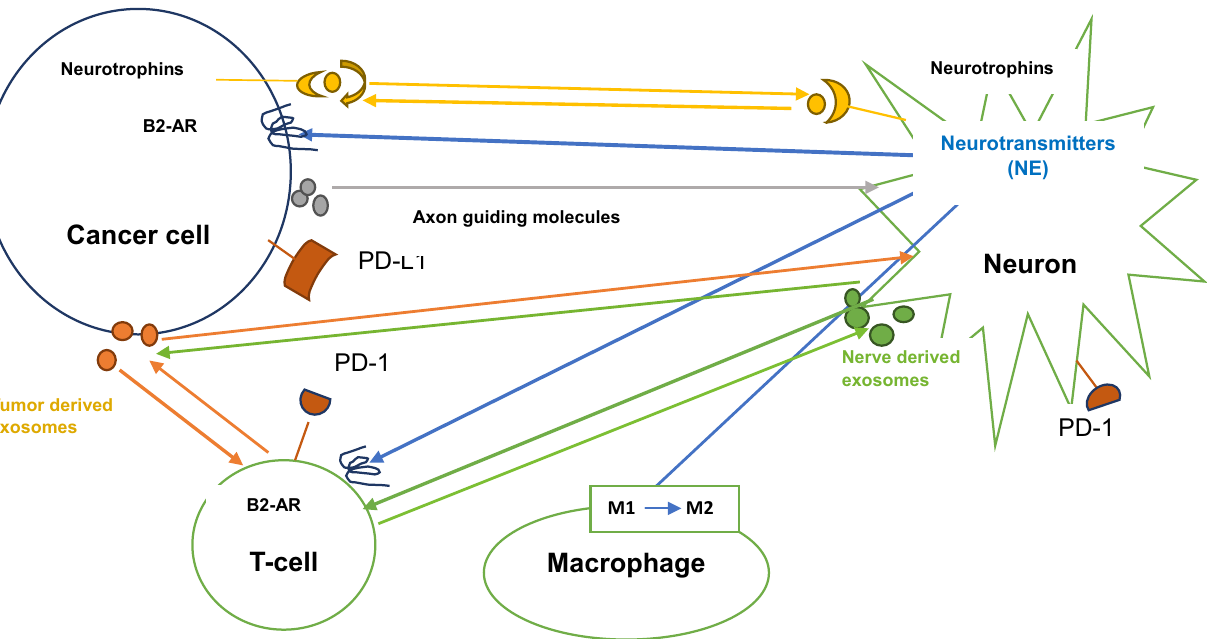
Fig. 1 Neuroimmune crosstalk in TME. Neurotrophins, neurotransmitters as norepinephrine (NE), their specific receptors and axon guiding molecules modulate activity of cancer cells and other components of TME. NE released by nerve cells influences cancer cells, T cells and induces M2 activation of macrophages. Expression of PD-1 on T cells and nerve cells and expression of PD-L1 on cancer cells alter immunity within TME. Tumor derived exosomes and nerve derived exosomes act as mediators between nerves, immune cells, malignant cells and TME. Tumor-derived and nerve derived exosomes impact T cell function within TME, leading to an immune-suppressive